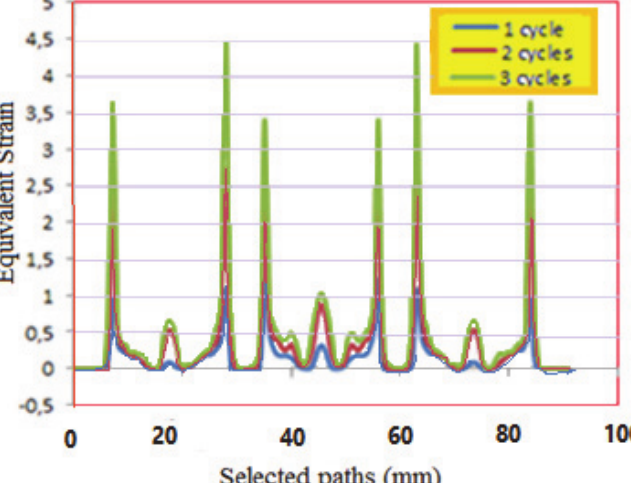
Figure 8: Influence of the number of cycles on the evolution of the plastic strain at the level of the upper